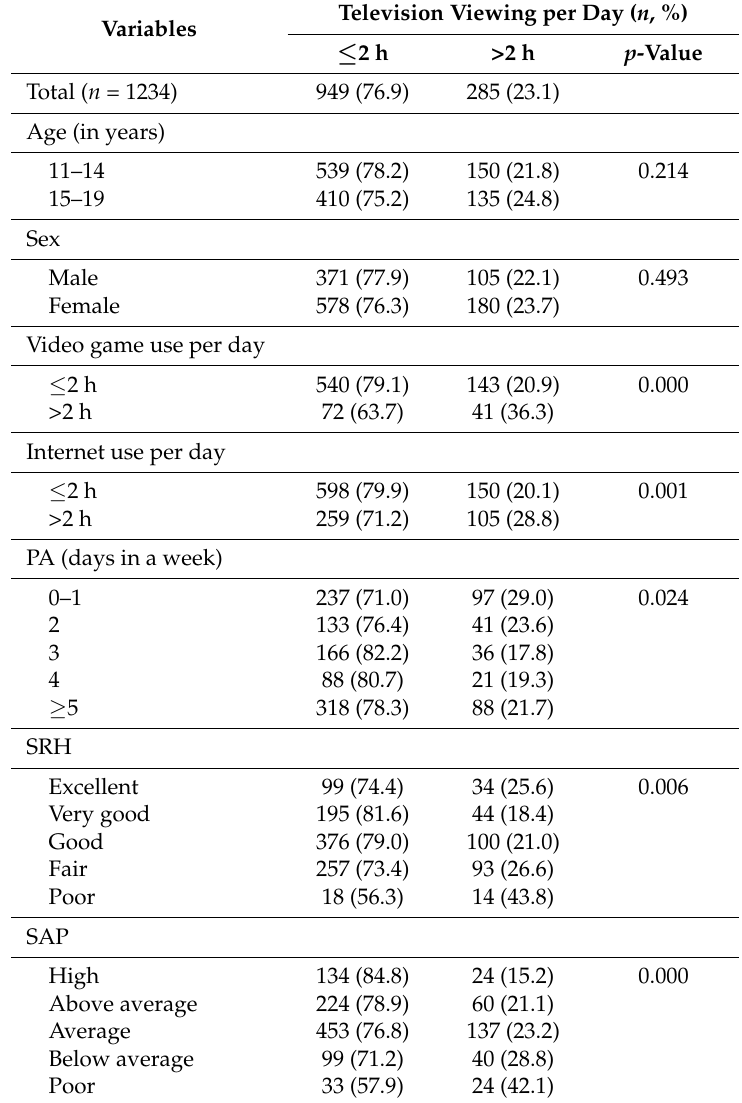
Table 2. Television viewing and its association with screen-based sedentary behaviors, PA, SRH and SAP.